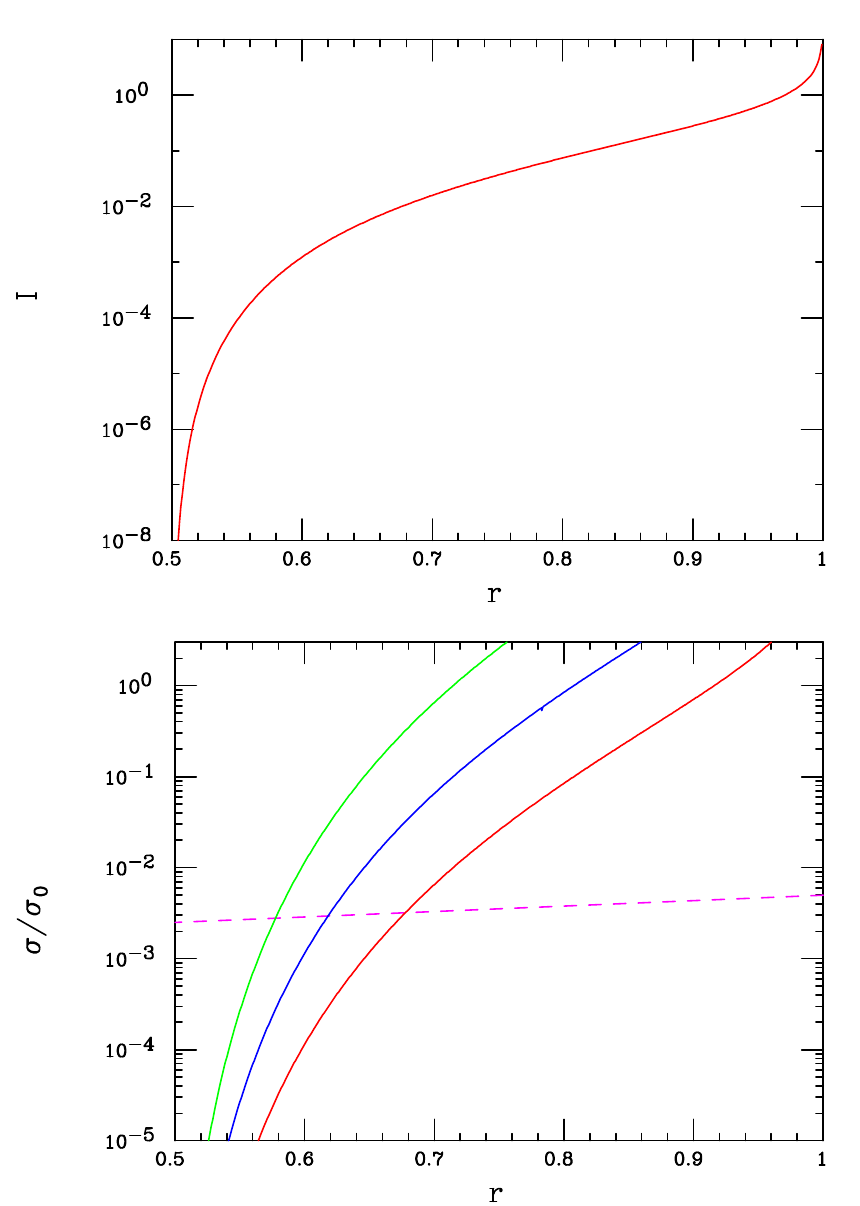
Figure 3 . (Top) Value of the phase space integral I as defined in the text as a function of the parameter r . Recall that as r → 1 both DPs can become on-shell. (Bottom) The cross section for the s -channel process φ † φ → V V ∗ , V ∗ → e + e − with v 2 = 0 , in units of σ 0 , as a function rel of r assuming, from bottom to top, that (cid:15) = 10 − (3 , 3 . 5 , 4) and assuming that m V = 100 MeV. The approximate upper bound on this cross section arising from the CMB [47] is shown as the dashed